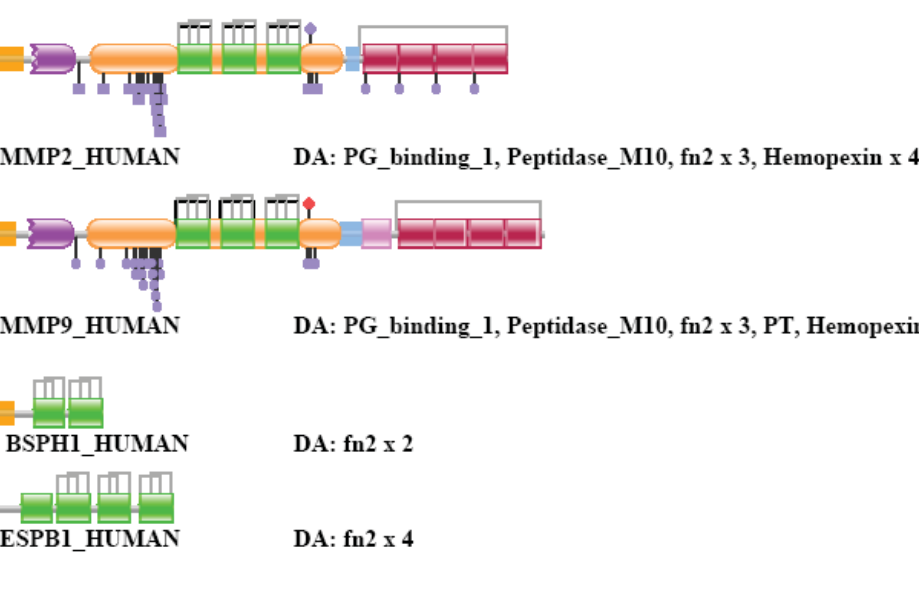
Figure S6. Comparison of the domain architecture of MMP2_HUMAN with those of its closest paralogs and some